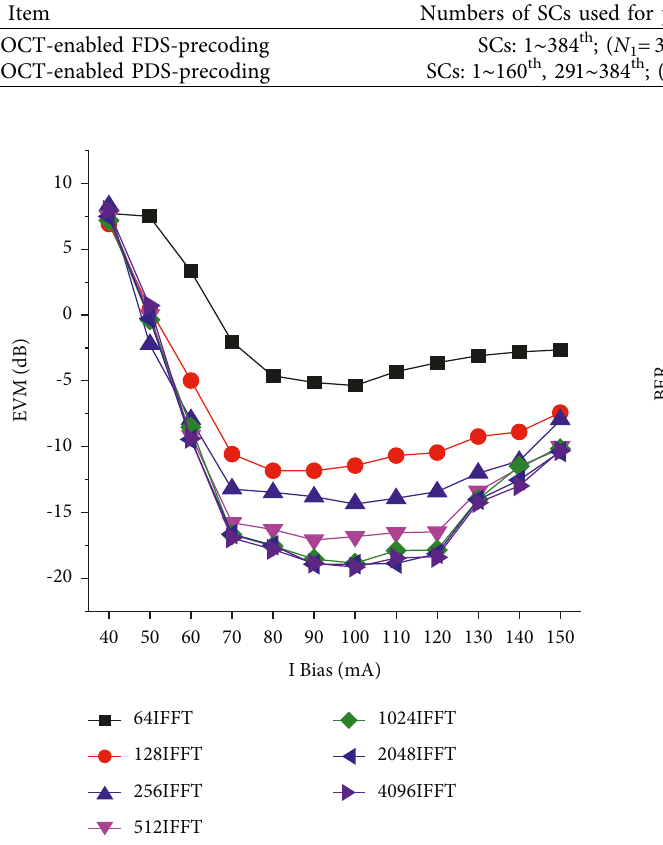
Figure 5: EVM performance versus I Bias. Figure 6: BER performance versus I